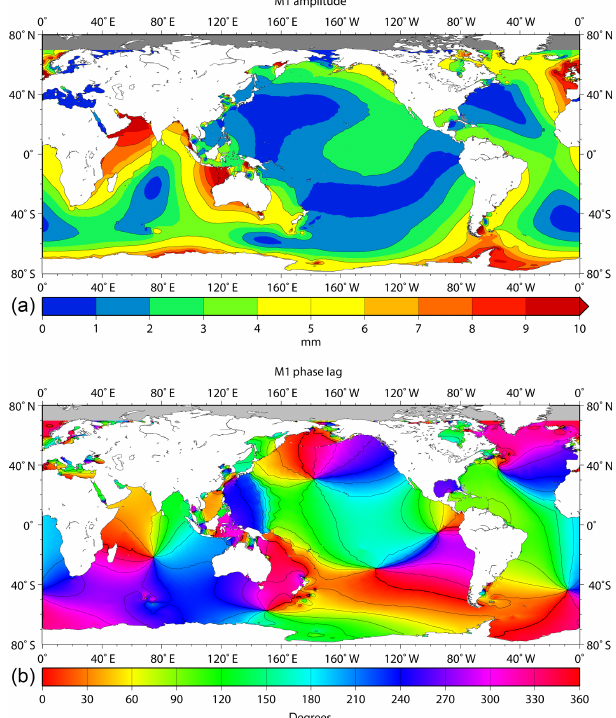
Figure 8. (a) Amplitudes and (b) Greenwich phase lags of M1 from the numerical